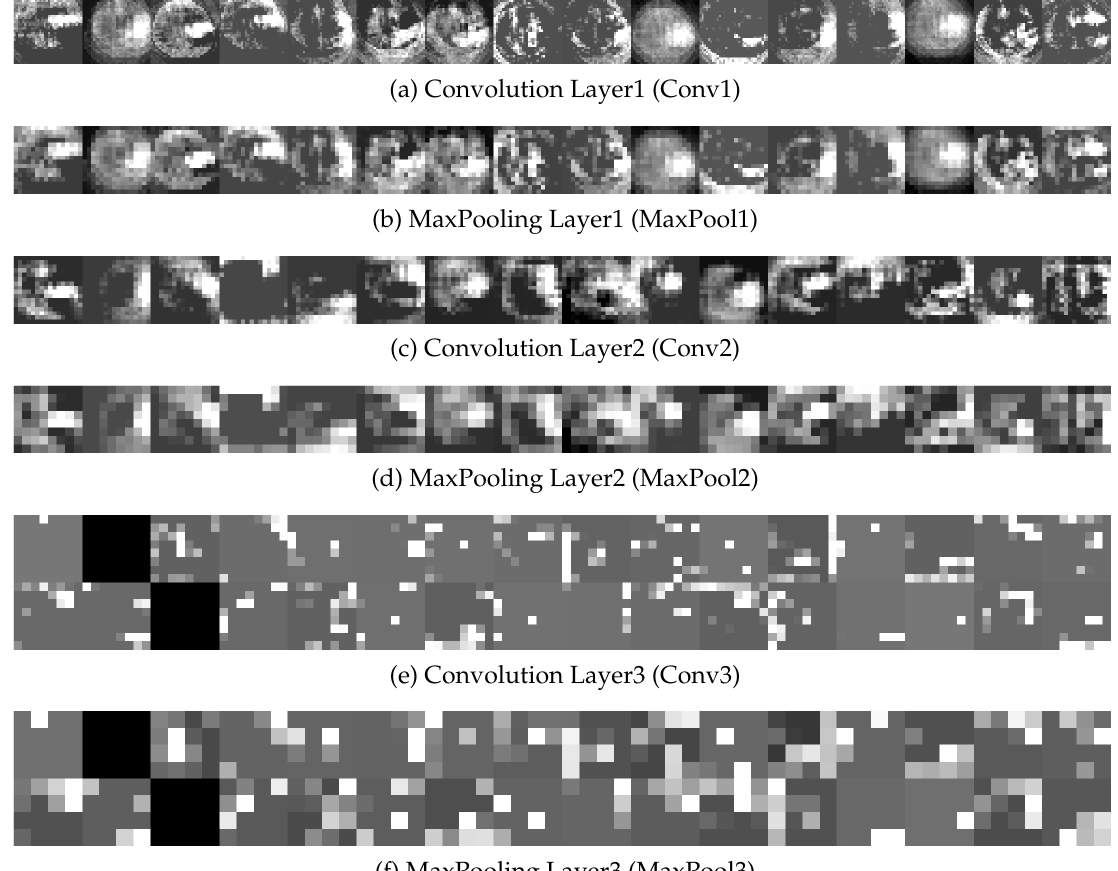
Figure 4. Activation maps for various layers of the Dilated CNN. Each of the three convolutional layers depicts the granularity of the generated features with coarse features generated in Conv1 and fine features in Conv3. The MaxPooling layers reduce the resolution of the generated features using a 2 × 2